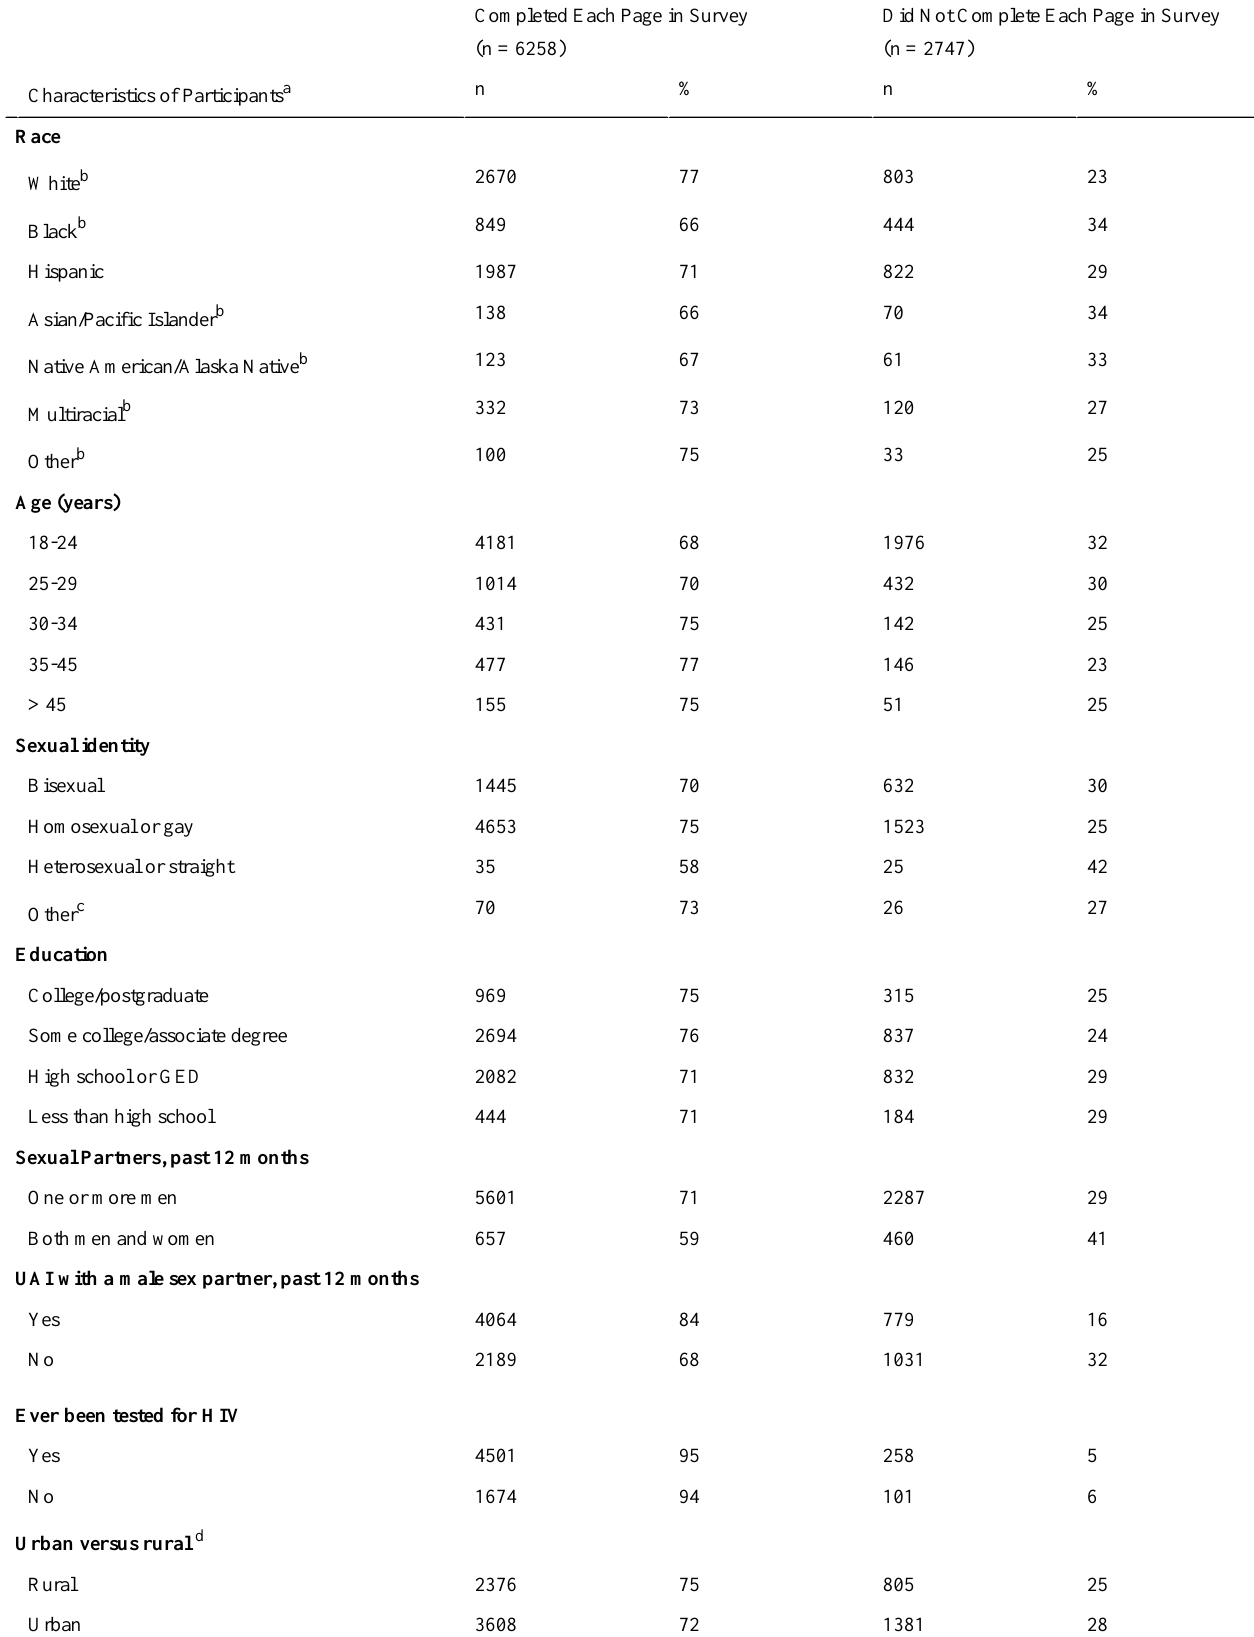
Table 3. Demographic characteristics of survey participants enrolled in an online HIV behavioral risk study by survey completion status (n = 9005) in the United States in